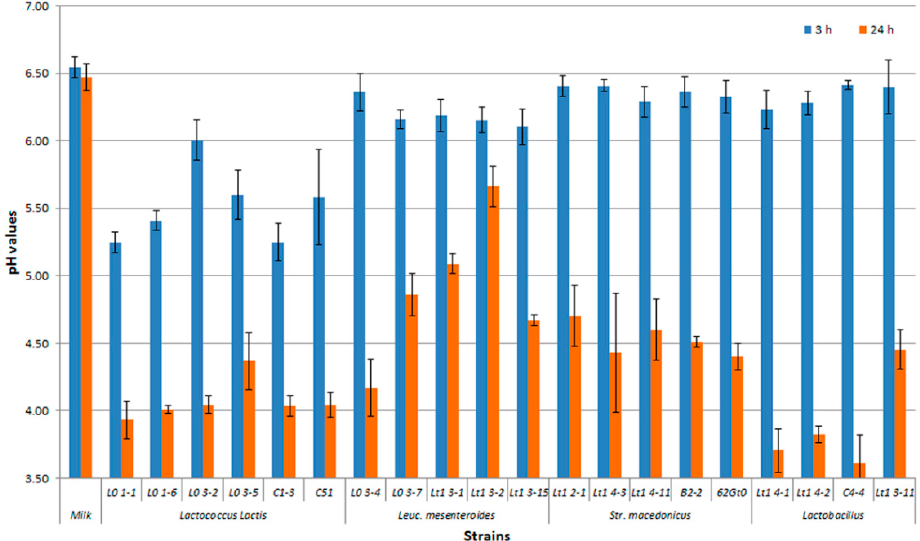
Figure 4. Values of pasteurized milk acidification of selected autochthonous lactic acid bacteria tested.